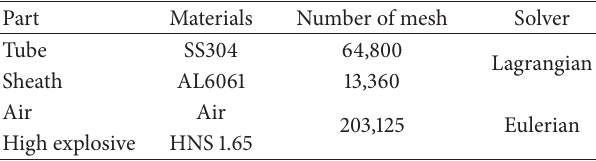
Figure 17: Pressure histories from gauge number 2. Table 4: Description of 3D expanding tube numerical model.